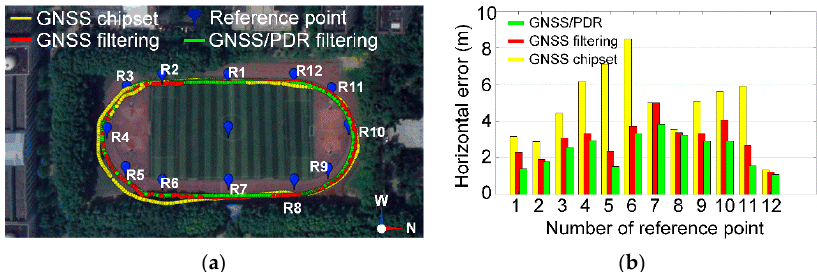
Figure 13. ( a ) is the comparison of the kinematic track; ( b ) is their horizontal position errors using